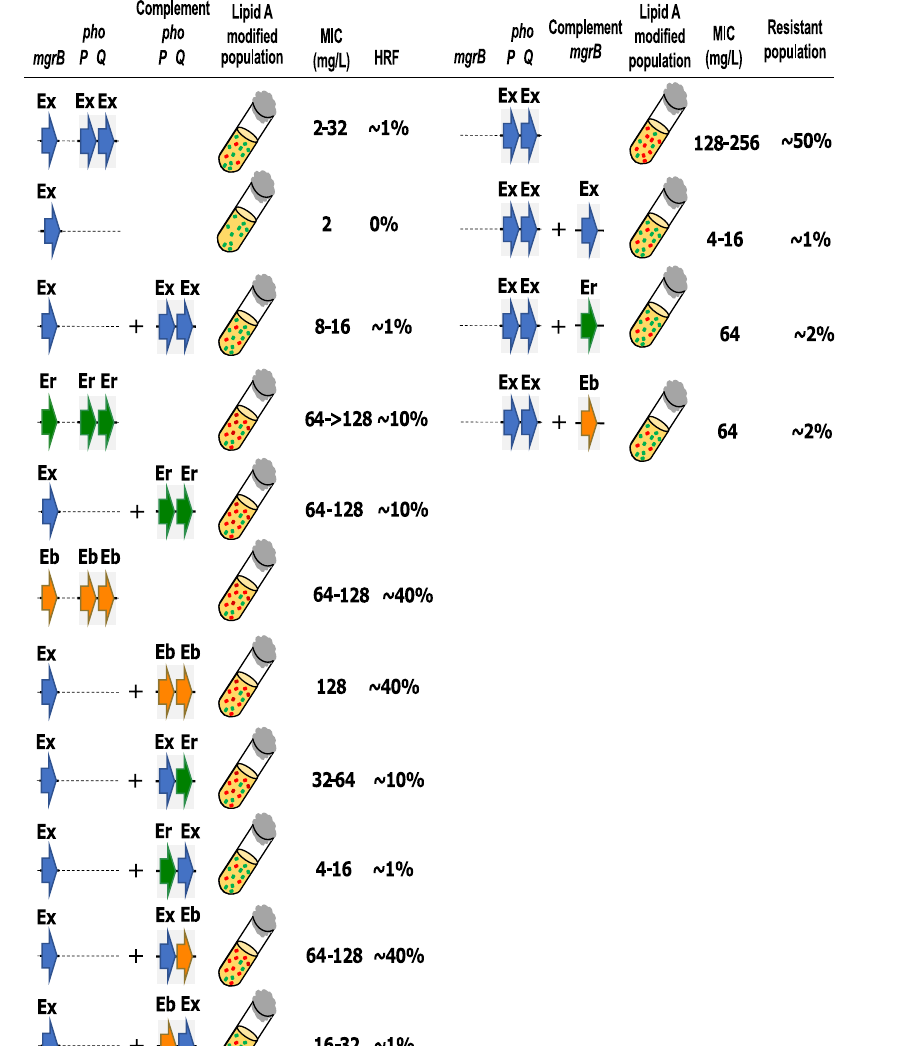
the Δ phoPQ mutant of E. xiangfangensis RBK-17-0394-1 resulted in the colistin resistance equivalent to respective parent strains. Complementation of the Δ mgrB mutant of E. xiangfangensis RBK-17-0394-1 with the mgrB from Eb (which has an identical amino acid sequence as of Er) resulted in slightly lesser inhibition due to changes in the binding energy (detailed in Supplementary Fig. 9). The MIC data is provided in the Source Data fi